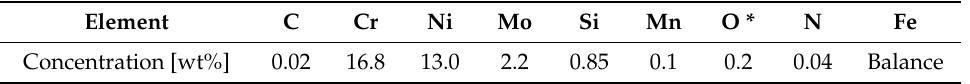
Table 1. Chemical composition of AISI 316L.